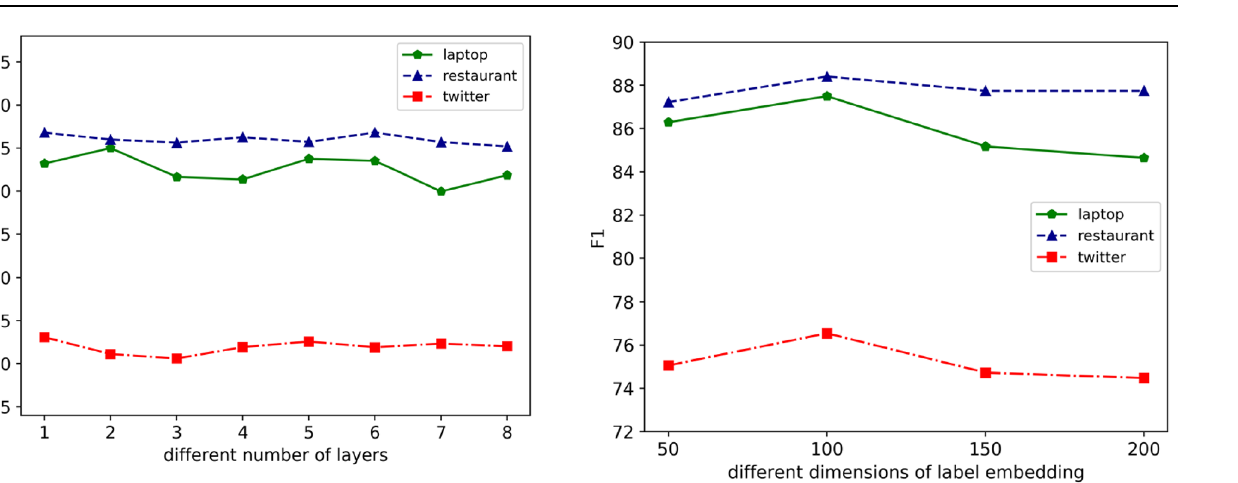
Fig. 14 F1 of IANN with respect to the different dimensions of label embedding on three datasets Effect of different sizes of the